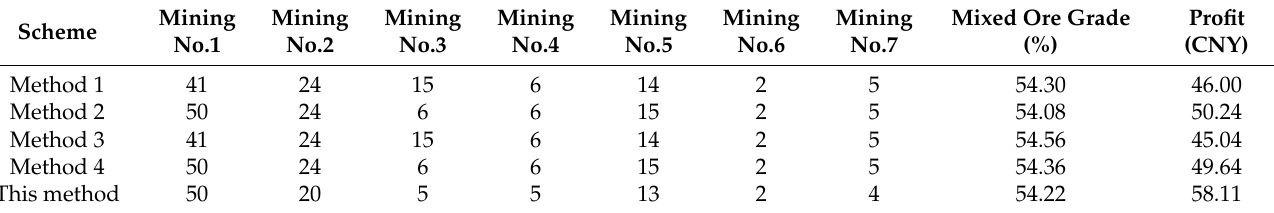
Table 9. Ore blending scheme in June.